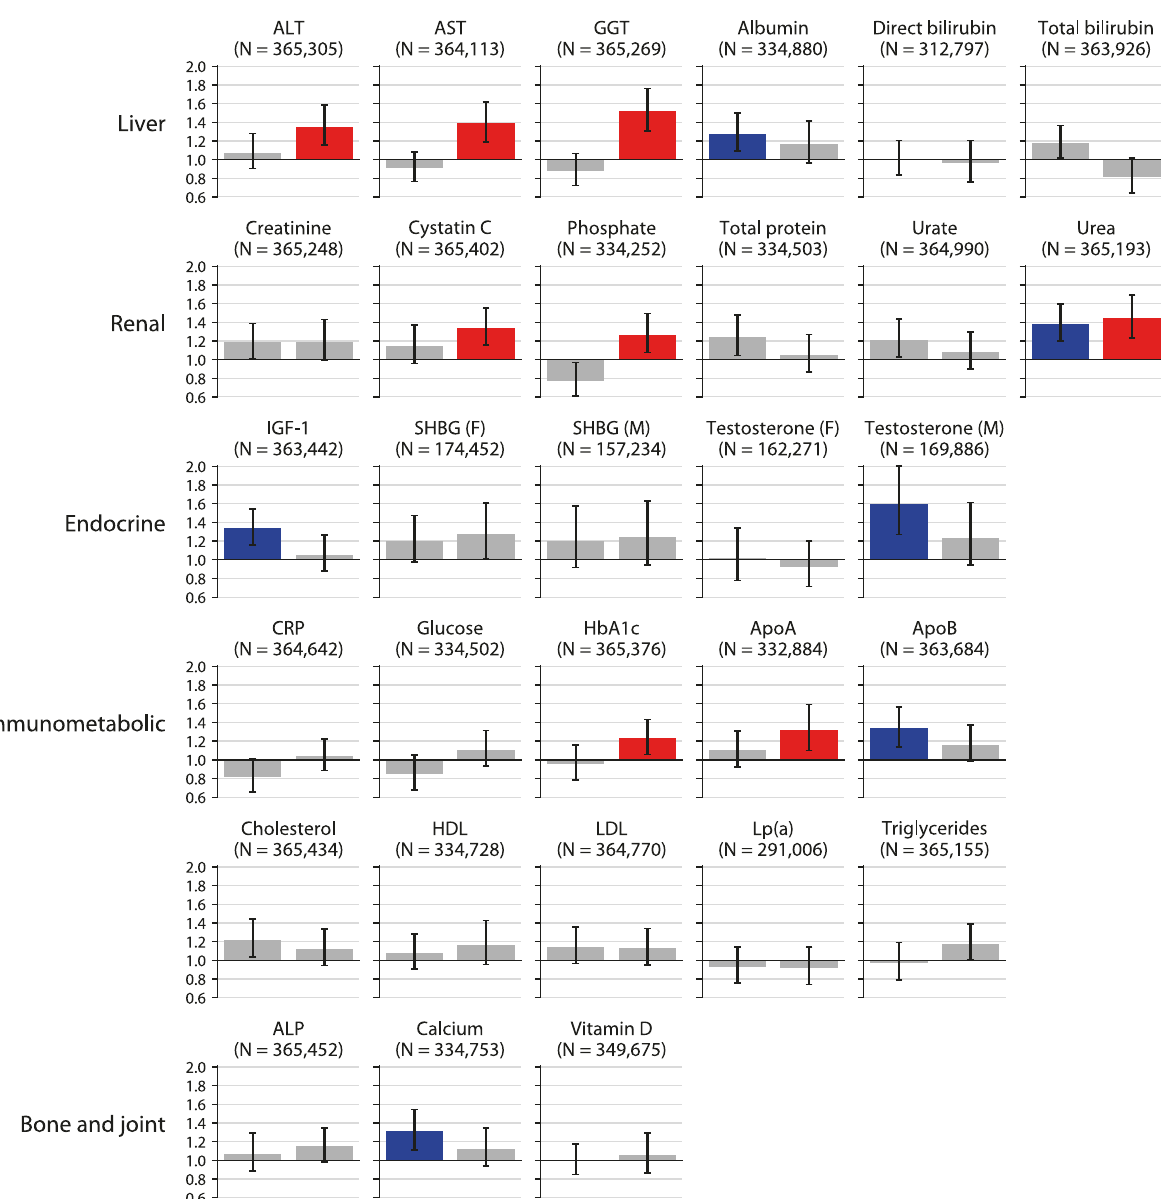
Fig. 1 Association of blood biochemistry tests with 5-year MDD incidence. Bars indicate the adjusted odds ratio of 5-year MDD incidence among individuals in the bottom 2.5% (left) or top 2.5% (right) of each blood test, after correcting for demographic, temporal, socioeconomic, and lifestyle factors. Signi fi cant associations at 5% FDR are denoted in blue (bottom 2.5%) or red (top 2.5%). Error bars denote 95% con fi dence intervals. Abbreviations are de fi ned in Table